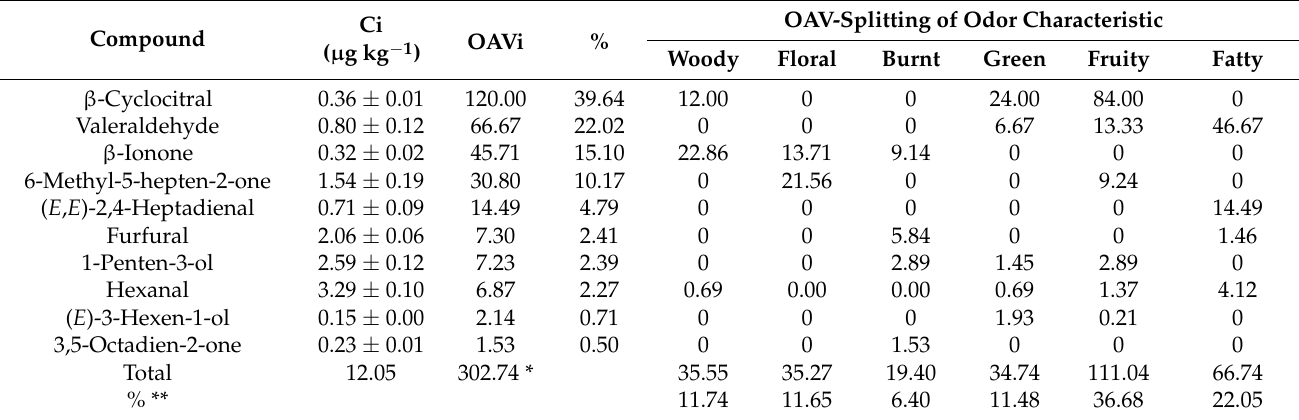
Table 3. The content, OAVi and OAV-splitting of key aroma compounds in oolong tea.